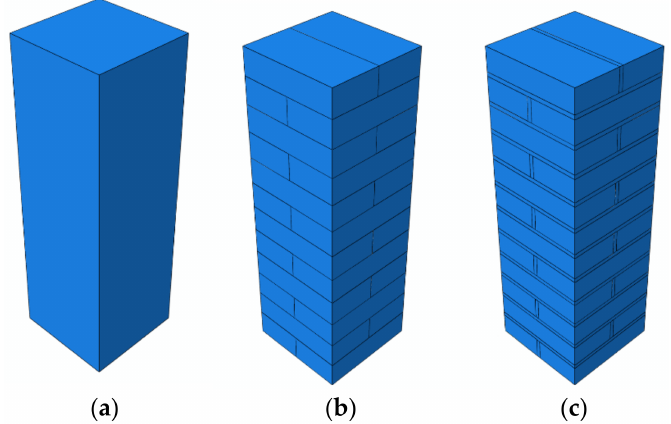
Figure 1. Numerical approaches: ( a ) macro; ( b ) simplified micro; ( c )